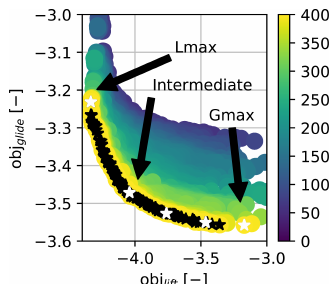
Figure 8. Pareto front example for the two-objective optimization with annotation of the two extreme and the intermediate objects. The colour bars refers to the generation of the